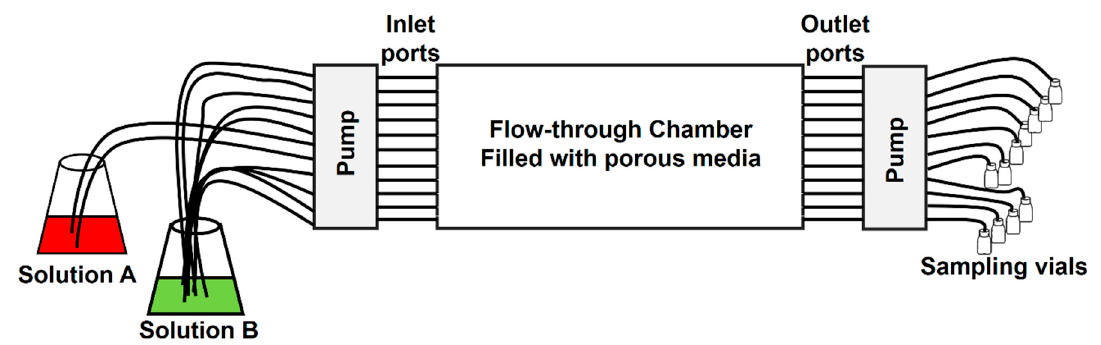
Figure 2. Two-dimensional Darcy-scale flow-through experimental setup: solutions are injected through inlet ports and extracted through outlet ports; constant-rate injection and extraction are realized by two high-precision pumps; samples are collected at the outlet channels.